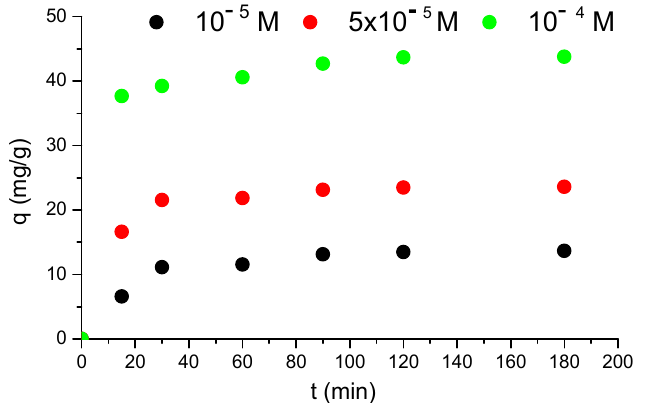
Figure 5. Impact of solution concentration on the MG adsorption using AP from aqueous solution.